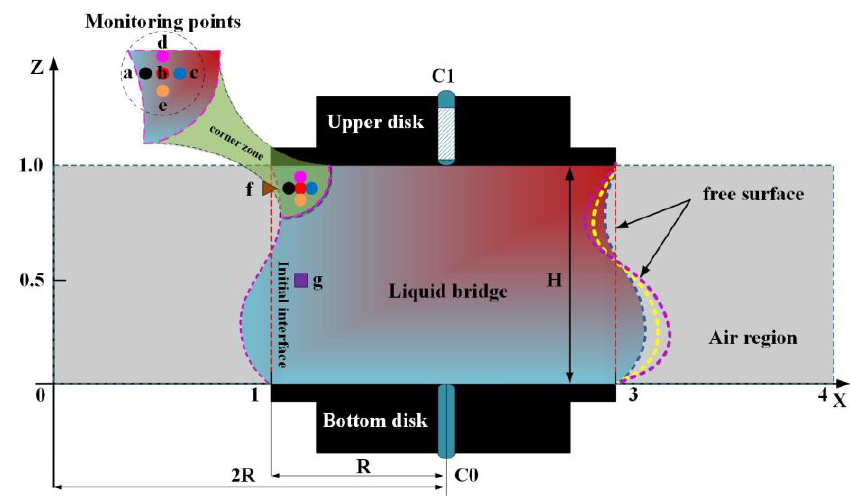
Figure 1. Schematic diagram of liquid bridge model.